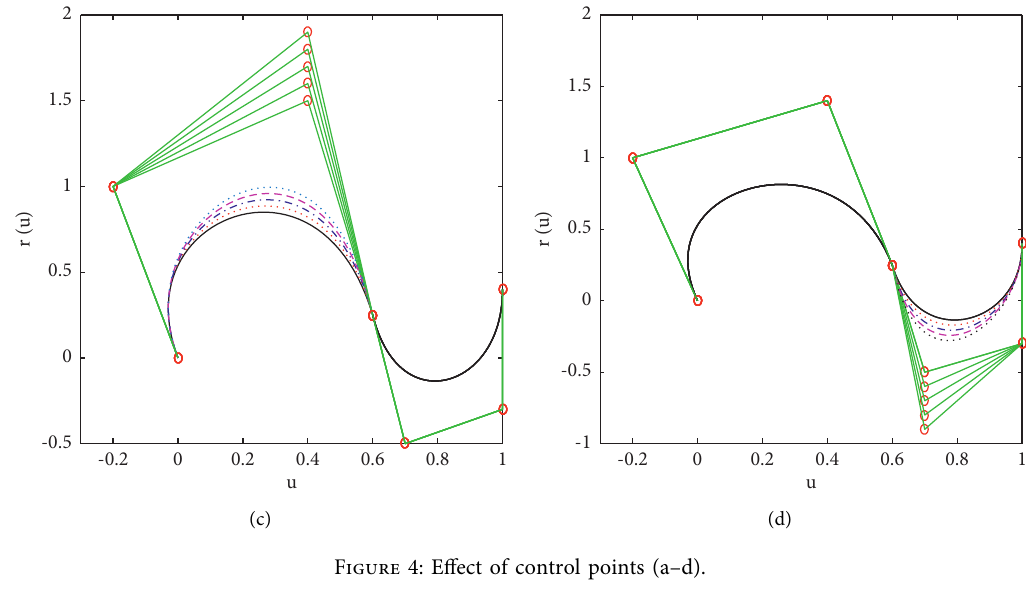
Figure 4: Effect of control points (a–d).